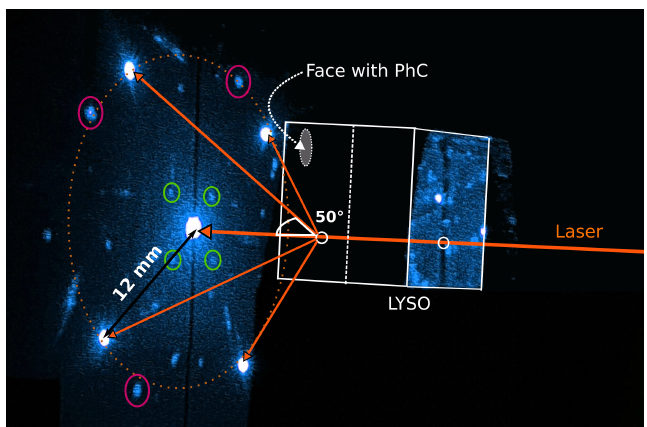
Figure 8. Experiment performed on an LYSO crystal with the PhC slab pattern on the readout face. A green laser is impinging from the face opposite the pattern, traveling inside the crystal and interacting with the PhC slab from the inside, as real scintillation photons would do. Diffraction orders are generated at an angle dependent on the periodicity of the pattern. The image is shown in false color to increase